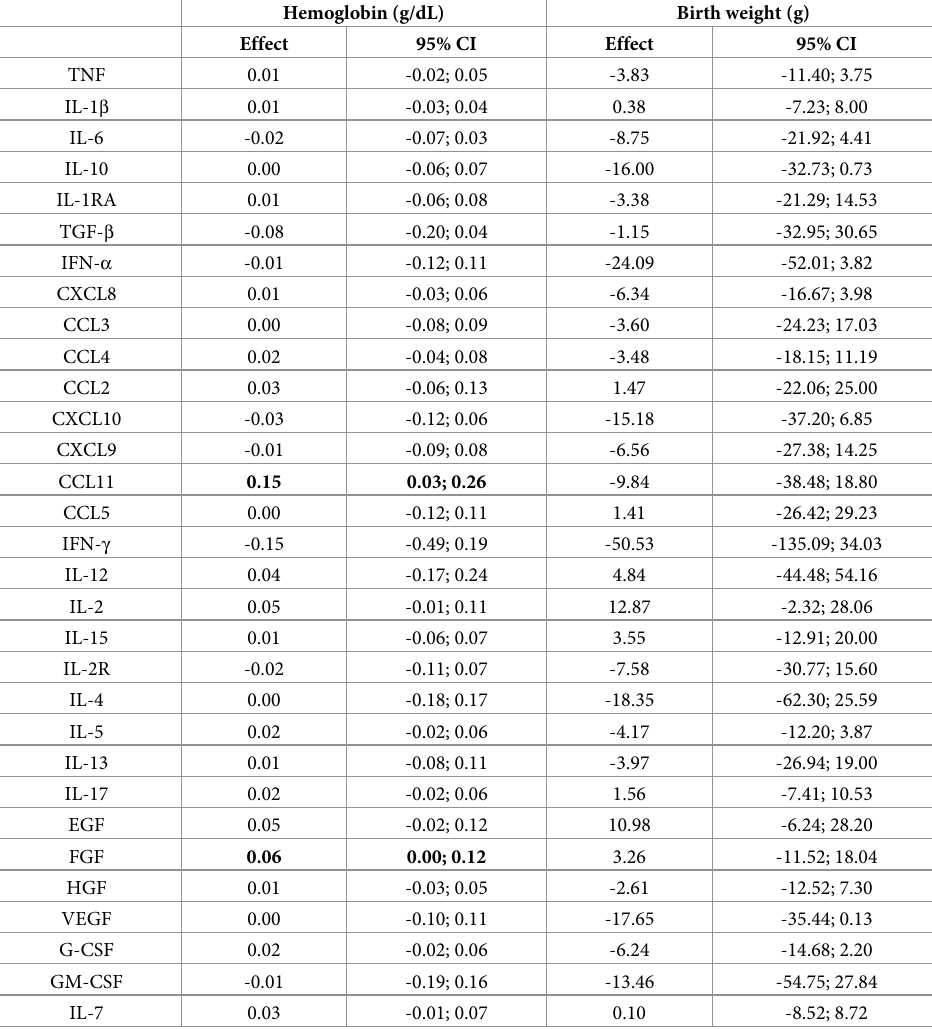
Table 5. Association of biomarkers at recruitment with hemoglobin levels at delivery and birth weight.